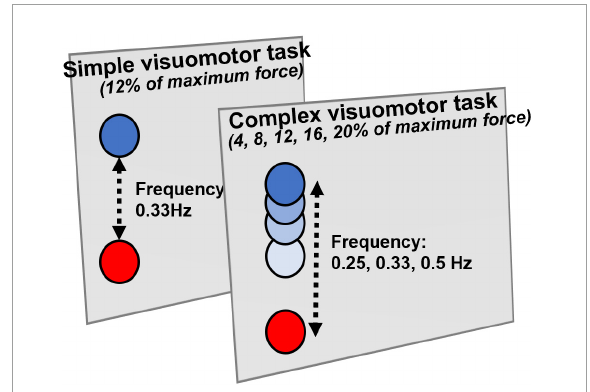
FIGURE1 Visual tracking task. The tension gauge was fixed to the right index finger, and the abduction tension was measured. The red circle indicates the controlled marker that moves up and down according to the abduction tension of the index finger. The blue circle displayed on the monitor is the target circle that moves from bottom to top. In the simple visuomotor task, the blue circle was set for only one motion pattern at 12% of the maximum abduction tension and a frequency of 0.33 Hz. In the complex visuomotor task, the blue circle was set to randomly move up and down within five moving ranges (0–4%, 0–8%, 0–12%, 0–16%, and 0–20%) of the maximum abduction tension of the index finger in three frequency ranges (0.25, 0.33, and 0.5 Hz). The subjects adjusted the abduction tension of the index finger so that the controlled marker exactly overlapped the blue target circle on the